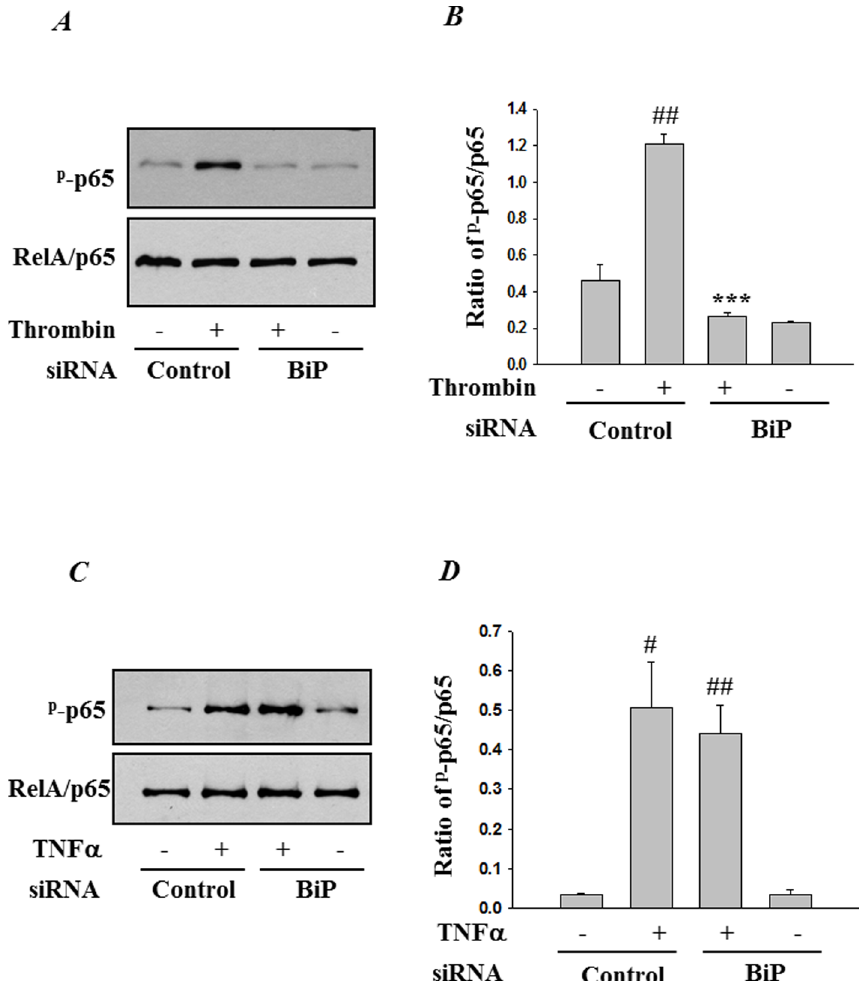
Figure 7. BiP knockdown markedly ameliorates thrombin-induced RelA/p65 phosphorylation at Ser 536 . HPAEC were transfected with control-siRNA or BiP-siRNA using DharmaFect1. After 24–36 h, the cells were challenged for 1 h with ( A ) thrombin or 0.5 h with ( C ) TNF a . Cell lysates were immunoblotted with an anti-phospho RelA/p65 (Ser 536 ) to determine the phosphorylation status of RelA/p65. The levels of total RelA/p65 were used to monitor loading. The bar graph represents the effect of BiP depletion on ( B ) thrombin or ( D ) TNF a -induced phosphorylation of RelA/p65 at Ser 536 normalized to total RelA/p65 levels. The data are the means 6 S.E. (n=3 for each condition). # p , 0.05 or ## p , 0.01 difference from controls; *** p , 0.001 difference from thrombin stimulated